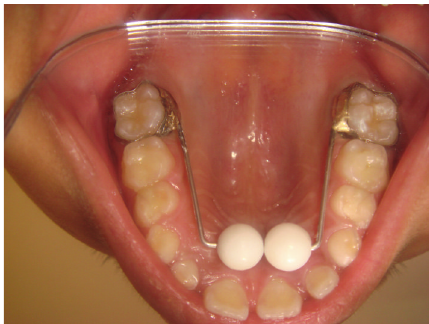
Figure 3: Modified blue grass